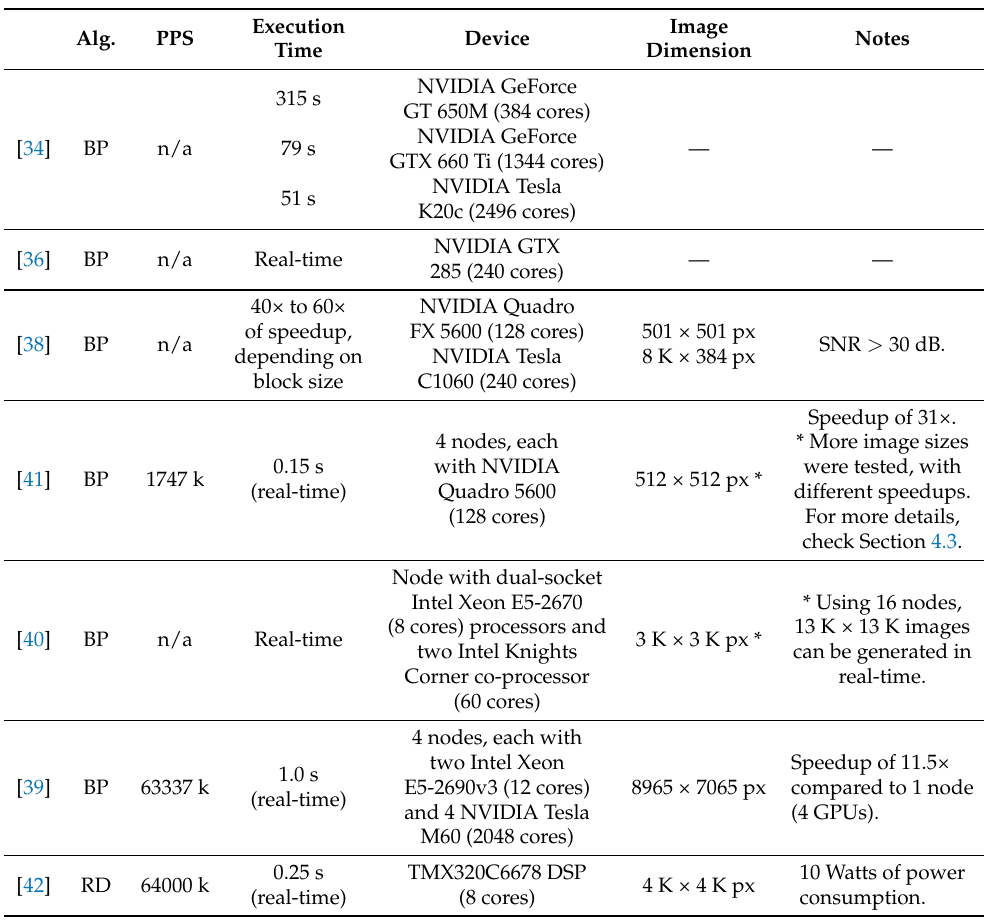
Table 7. Comparison between the different GPU/many-core implementations of SAR image forma- tion algorithms described in Section 4.3. This table includes the implemented algorithm, execution time and average pixels per second (PPS), whether is real-time, device used and number of cores, image dimension, speedups and additional